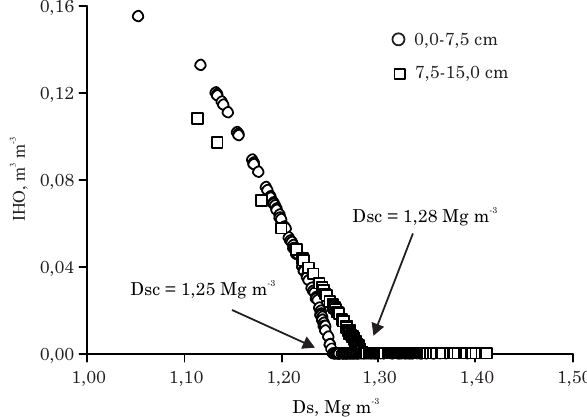
Figura 2. Variação do intervalo híbrido ótimo (IHO) e da densidade do solo (Ds) e respectivos valores da densidade crítica do solo (Dsc) nas camadas de 0,0-7,5 e 7,5-15,0 cm.